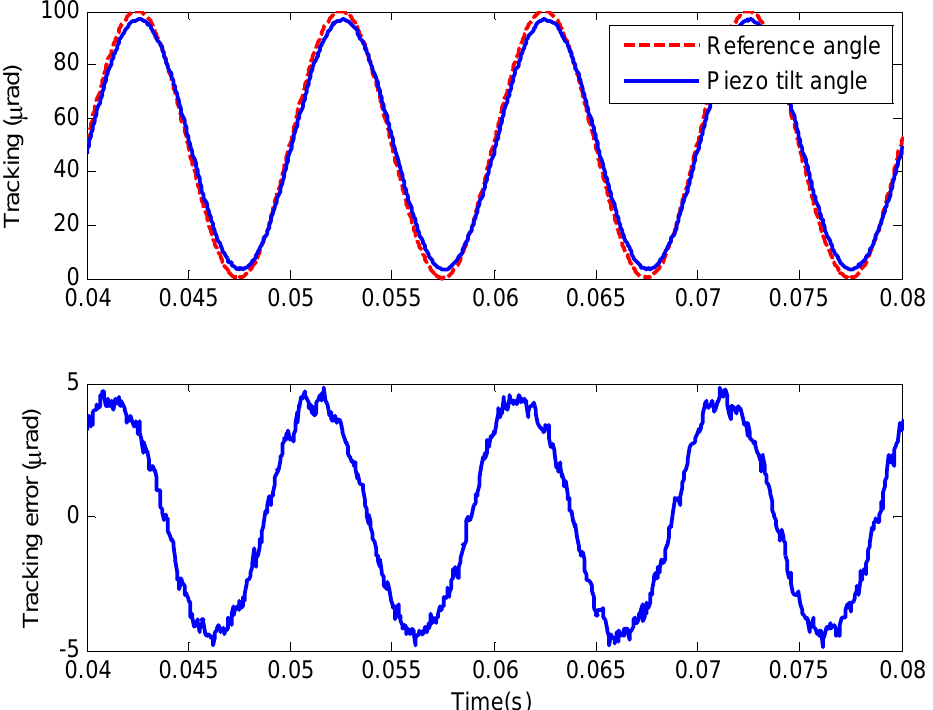
Figure 15. Tracking performance of sinusoidal wave at 100 Hz under the composite control.